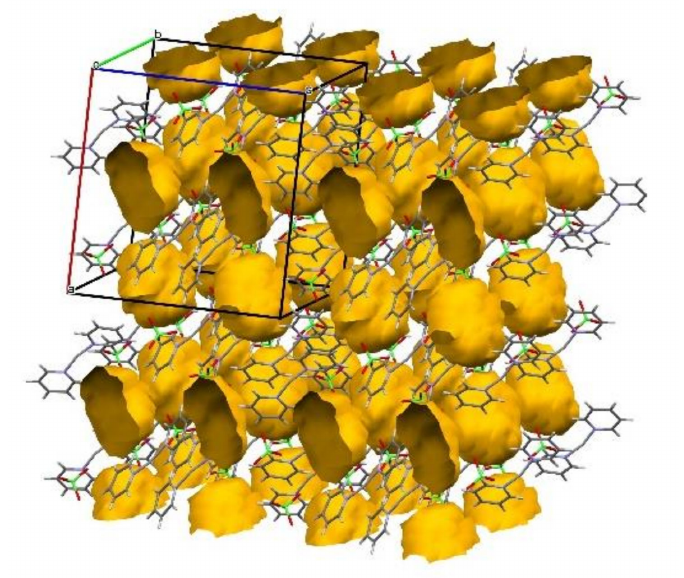
Figure 6. The voids accessible for the solvent pyridine in compound 1 . The voids of the solvent molecules occupy 18.0% of the unit